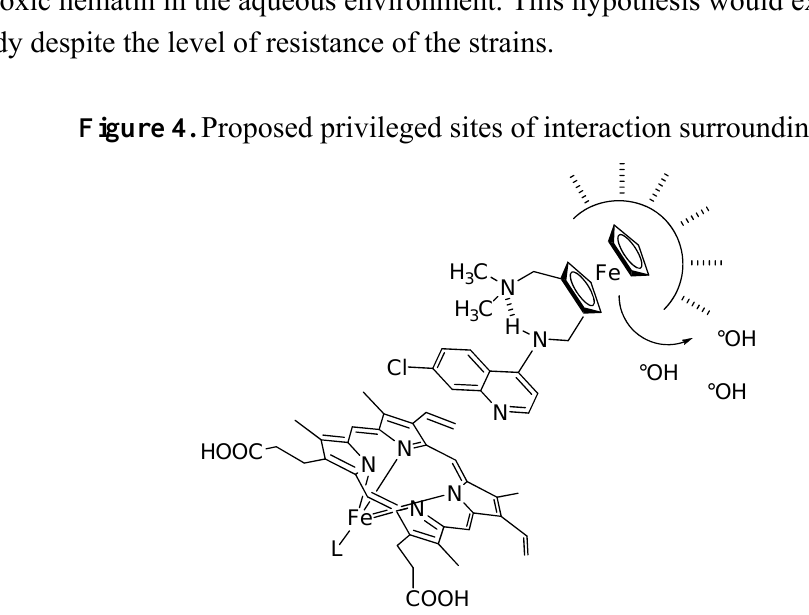
L stands for a molecule of water or another molecule of ferriprotoporpphyrin